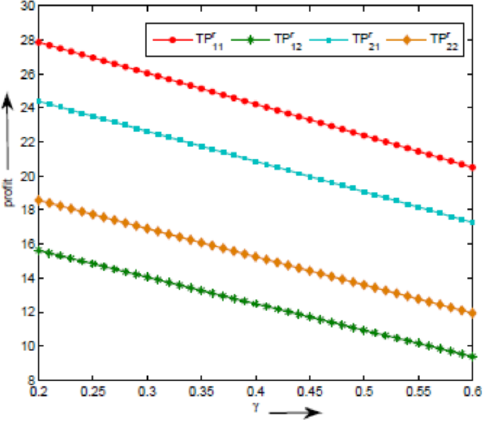
Fig. 1. Impact of competition on retailers’ profit Fig. 2. Impact of competition on manufacturer’sand entire